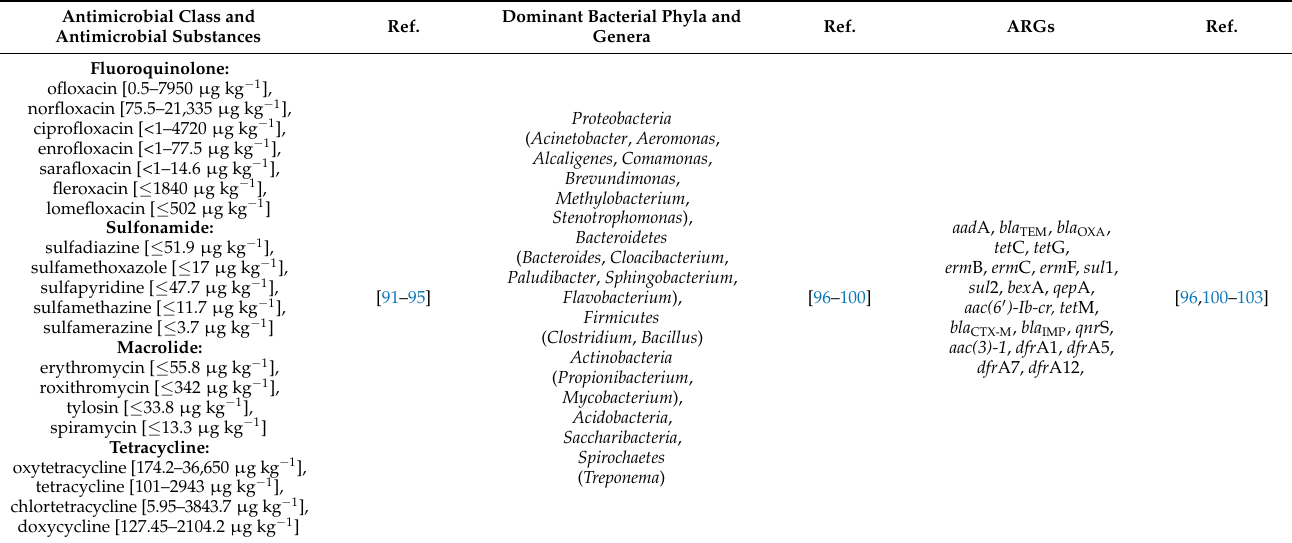
Table 4. Antimicrobials, microorganisms and ARGs detected in sewage sludge. Antimicrobial Class and Dominant Bacterial Phyla and Antimicrobial Substances Ref. Genera Ref. ARGs